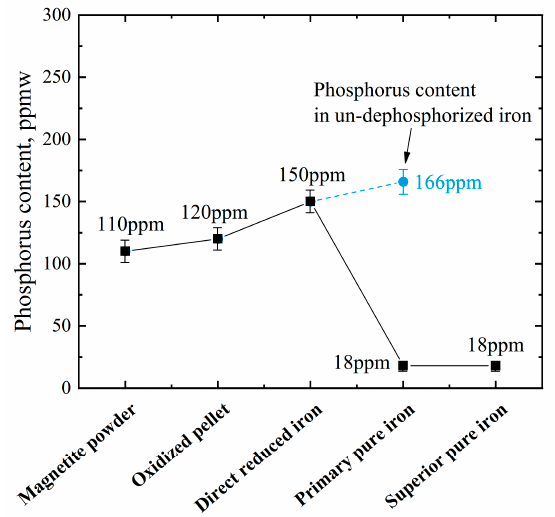
Figure 4. The change in phosphorus content in each step.